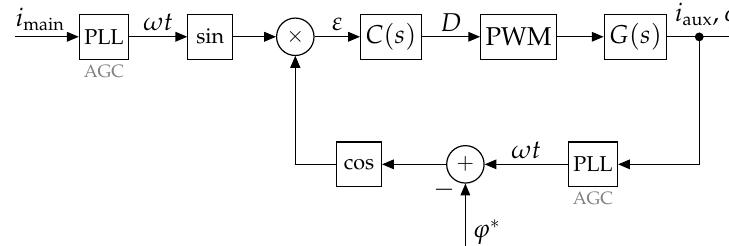
Figure 15. A simplified block diagram with nonlinearities of the closed-loop control of current phase advancing with the mixer as a phase